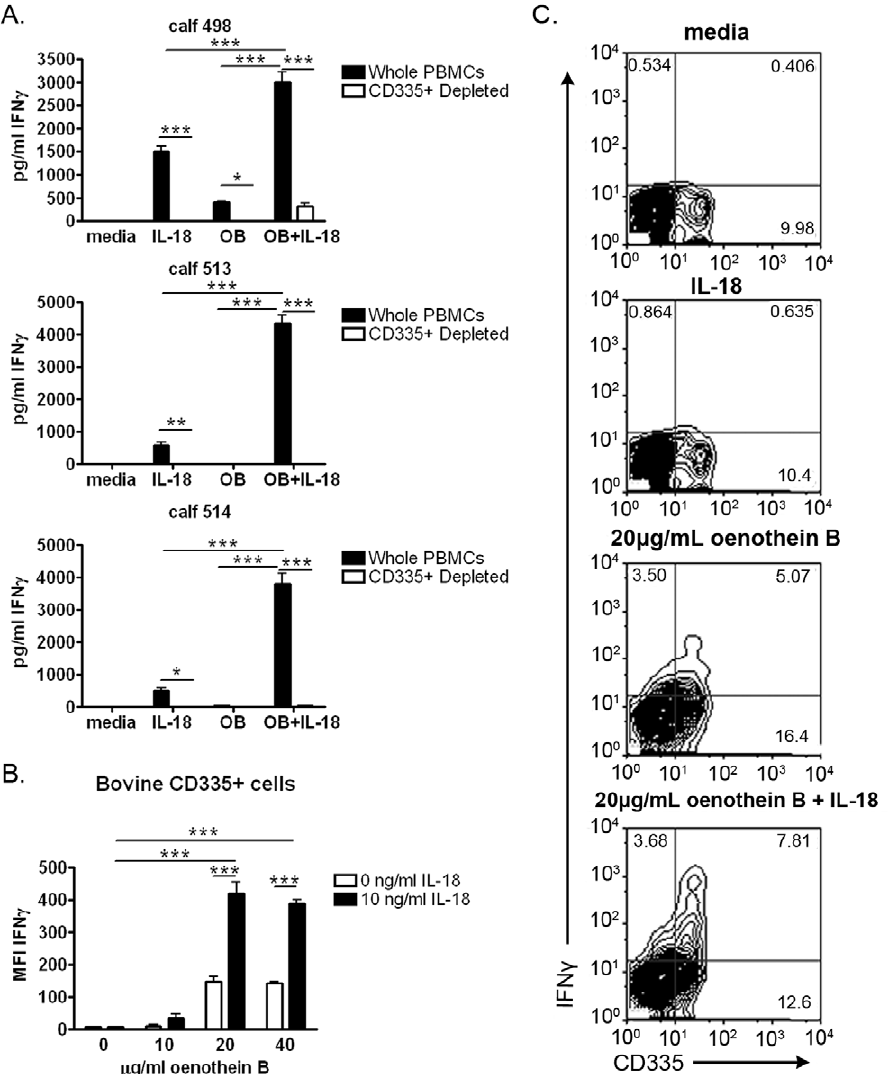
Figure 4. Oenothein B Primes bovine CD335 + cells to respond to IL-18. (A) Bovine PBMCs (10 5 cells/well) were depleted of CD335 + cells and treated with 20 m g/ml oenothein B or X-VIVO medium alone for 24 hrs. Cells were then washed and treated with 10 ng/ml rhu IL-18 or medium alone for 18 hrs. After incubation, IFN c levels in the supernatant fluids were measured by ELISA. The data are expressed as mean + / 2 SEM of three independent experiments comparing depleted PBMCs to un-depleted controls tested concurrently. All samples were tested in duplicate or triplicate. Statistical significance was measured by Two-way ANOVA with Bonferroni post-test. *p , 0.05, **p , 0.01, ***p , 0.001 (B) Bovine PBMCs (10 5 cells/well) from a new calf were treated with the indicated amounts of oenothein B or X-VIVO medium alone for 24 hrs. Cells were washed and treated with 10 ng/ml rhu IL-18 or X-VIVO medium alone for 6 hrs in the presence of brefeldin A. IFN c production was measured by intracellular flow cytometry. The data are expressed as mean + / 2 SEM. All samples were tested in triplicate. Statistical significance was measured by Two-way ANOVA with Bonferroni post-test. *p , 0.05, **p , 0.01, ***p , 0.001 (C) Representative examples of two-color flow cytometry plots comparing IFN c staining on CD335 +